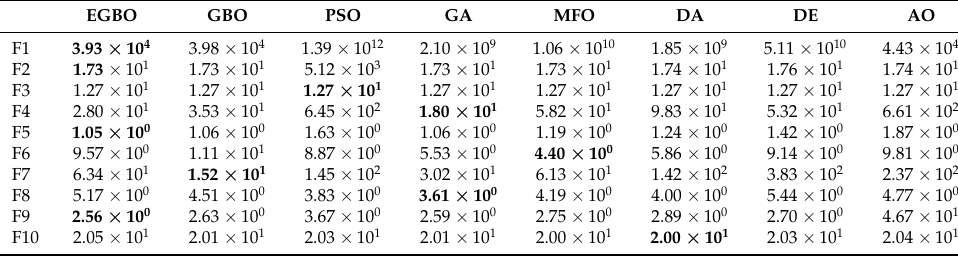
Table 4. Results of the min measure of the fitness function values.